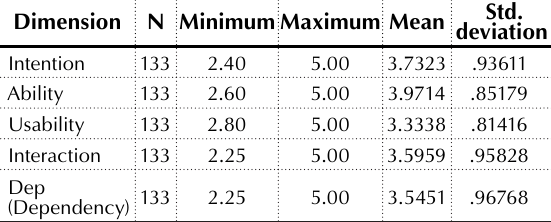
Table 13. Model summary